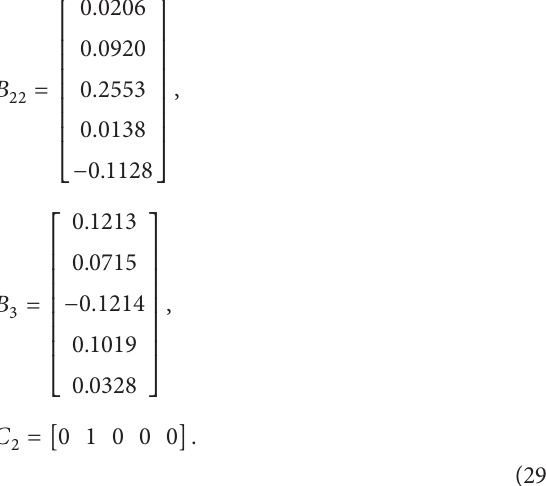
Simulation 1. Let the packet loss probability value 𝛼 = 0.3 , and given the initial conditions as 𝑥 1 (0) = [1 0.2 0.2] (0) = [0.9000 0.4189 0.7843 0.6498 1.0000] 𝑇 , the sim- 𝑥 2 ulation time is 𝑇 = 20 s, sampling time is ℎ = 0.01 s, and assuming that the two network-induced delays are both equivalent to 𝜏 𝑘 , which is not longer than the sampling period, = 0.005 s. The goal of this simulation is to design the 𝜏 𝑘 controller gains such that the closed-loop system is robustly stable with a disturbance attenuation level 𝛾 > 0 . The